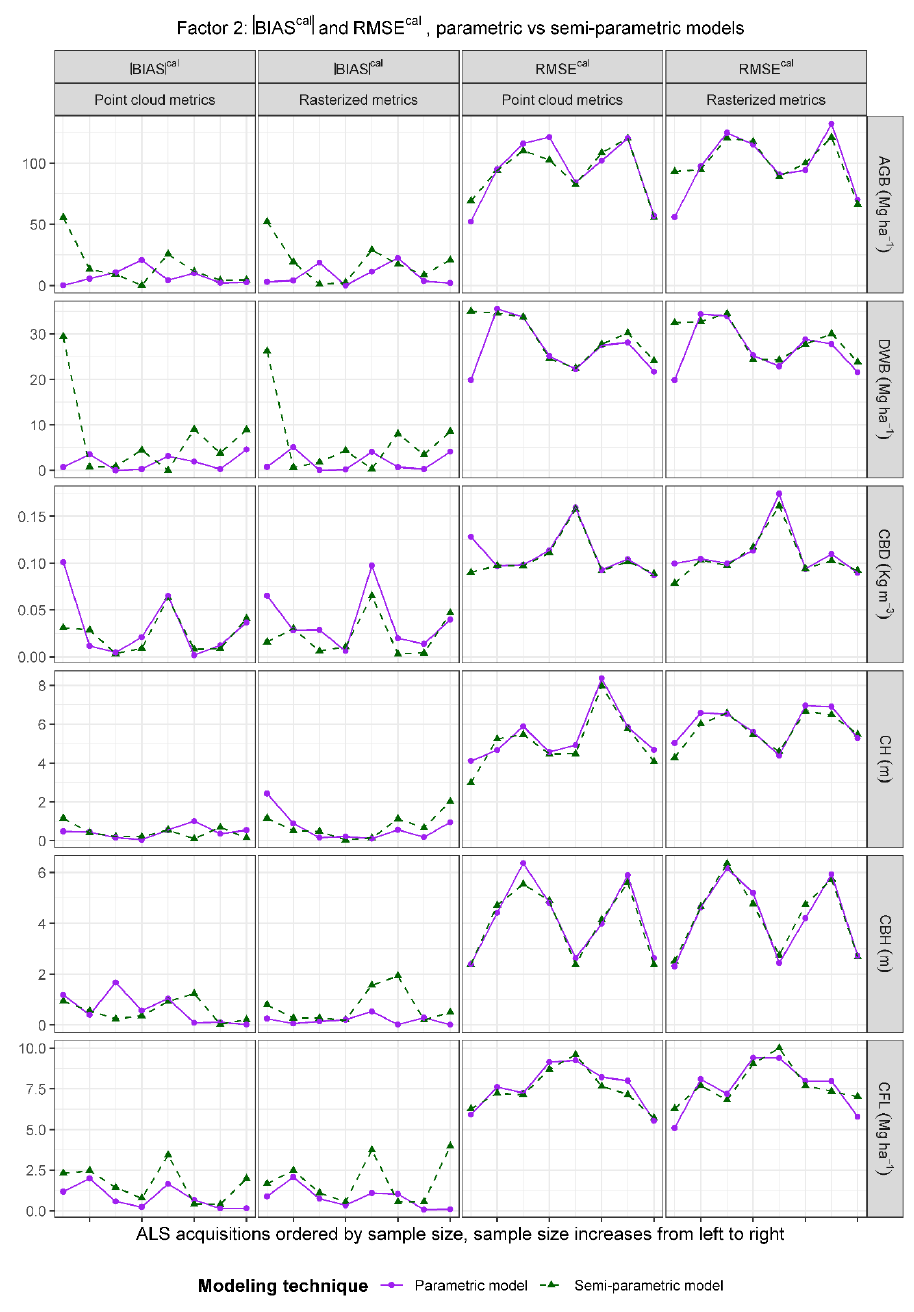
(cid:12) (cid:12) (cid:12) (cid:12) cal (cid:12) BIAS (cid:12) , and root mean squared error, RMSE